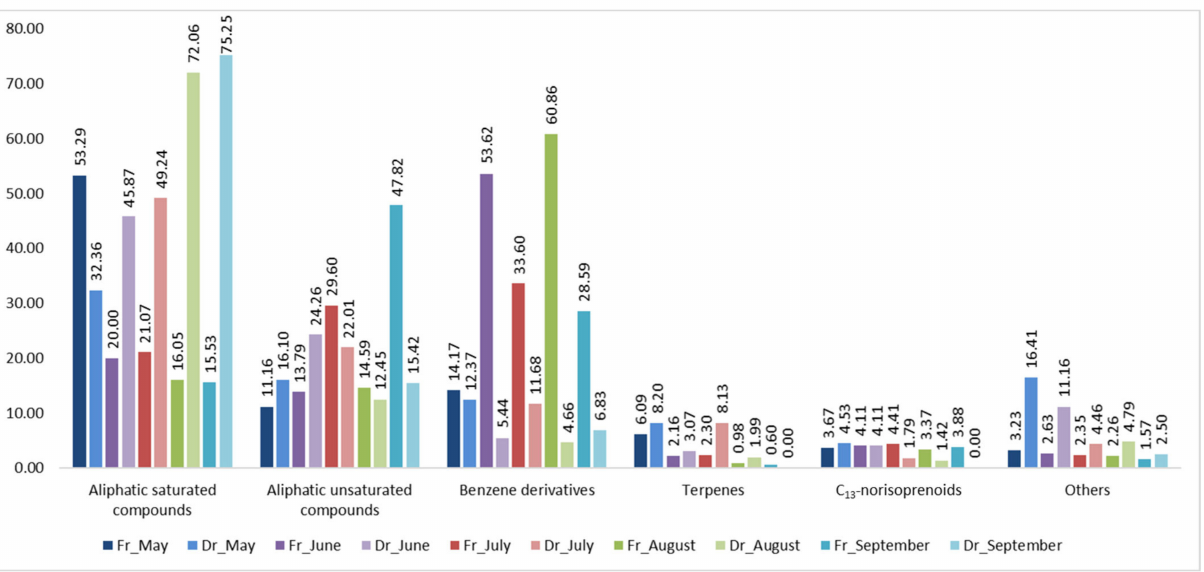
Figure 3. The VOCs from H. scoparia sorted by structural groups extracted by headspace solid-phase microextraction (HS-SPME) and analysed by gas chromatography–mass spectrometry (GC–MS) using PDMS/DVB fibre (f2); Fr (fresh), Dr